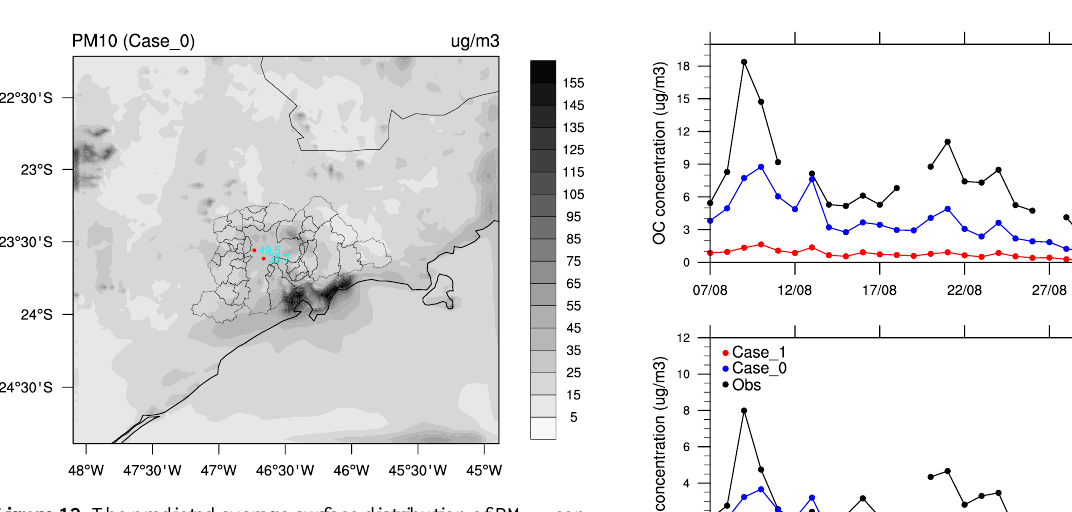
Figure 13. The predicted average surface distribution of the PM 2 . 5 :PM 10 ratio for the whole study period in the 3km modelling domain. Red dots represent the locations of the measurement sites with information on both PM 2 . 5 and PM 10 , whereas cyan numbers represent the observed average PM 2 . 5 :PM 10 ratio in those sites: 0.43 in IAG-USP and 0.57 in CON.